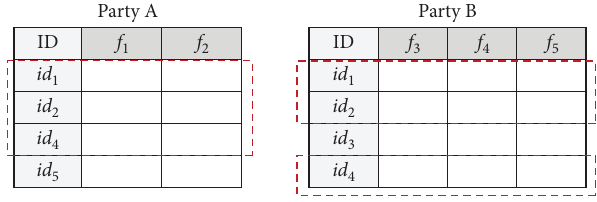
Figure 2: Data split of parties in vertical FL. Te horizontal axis denotes sample ID, and the vertical axis denotes